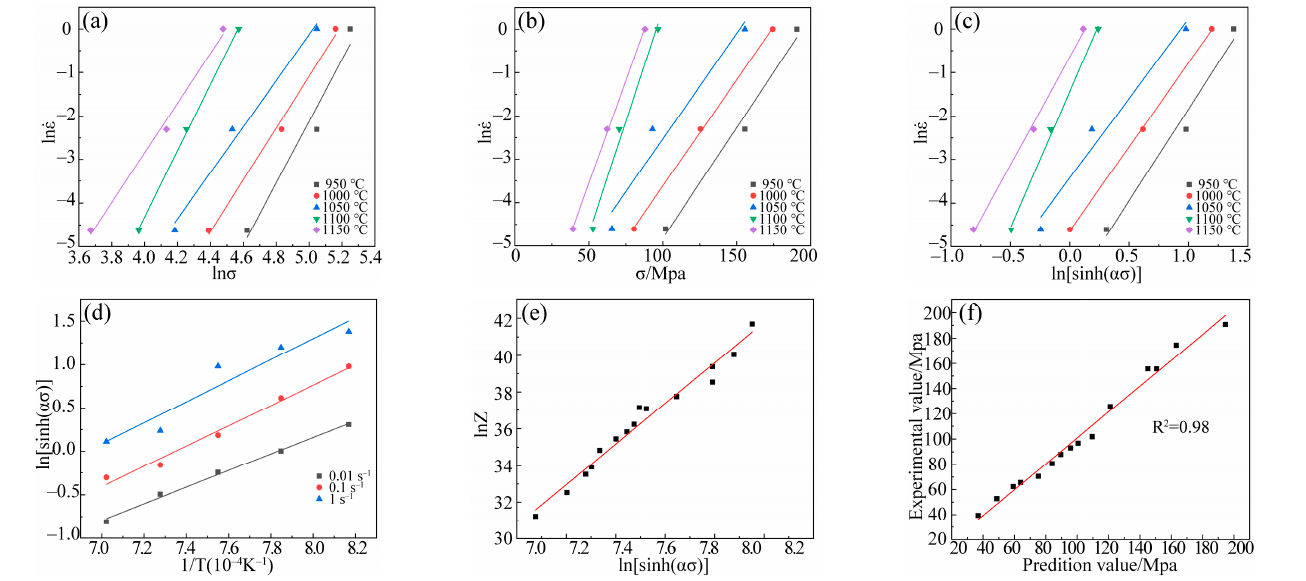
Figure 3. The fitting relations from the constitutive model, i.e., ( a ) ln . ε − ln [ sinh ( ασ )] , ( d ) 1/ T − ln [ sinh ( ασ )] , ( e ) ln Z − ln [ sinh ( ασ )] and ( f ) R 2 ( c ) ln